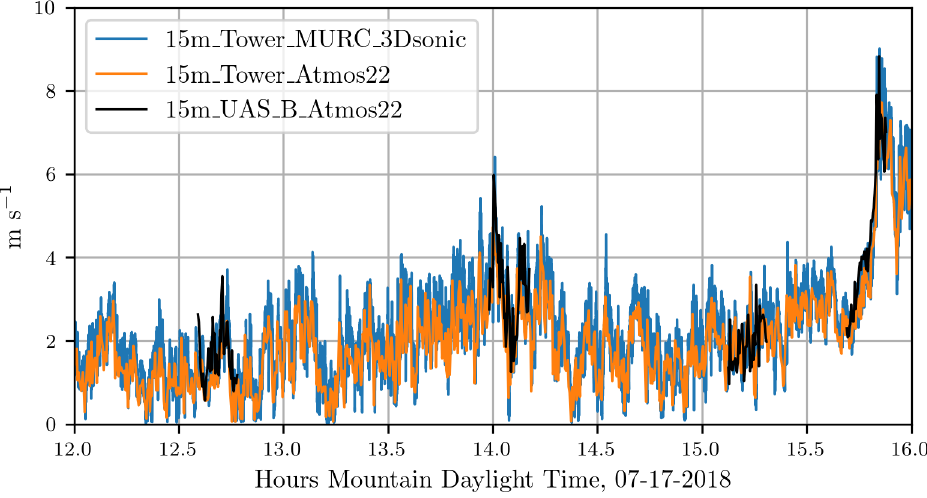
Figure 10. Comparison of wind speed measurements from UAS B and ground-based